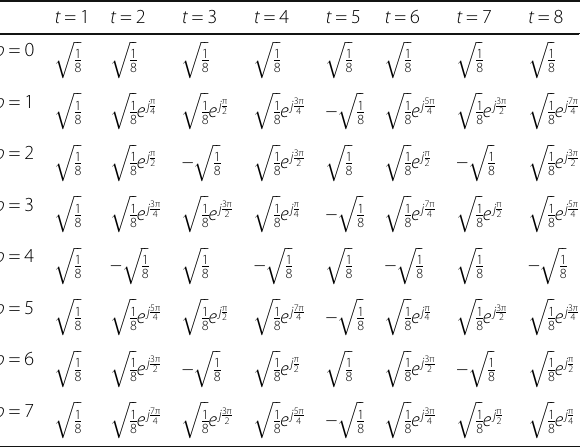
Table 3 GLPSM coding coefficients for N T =